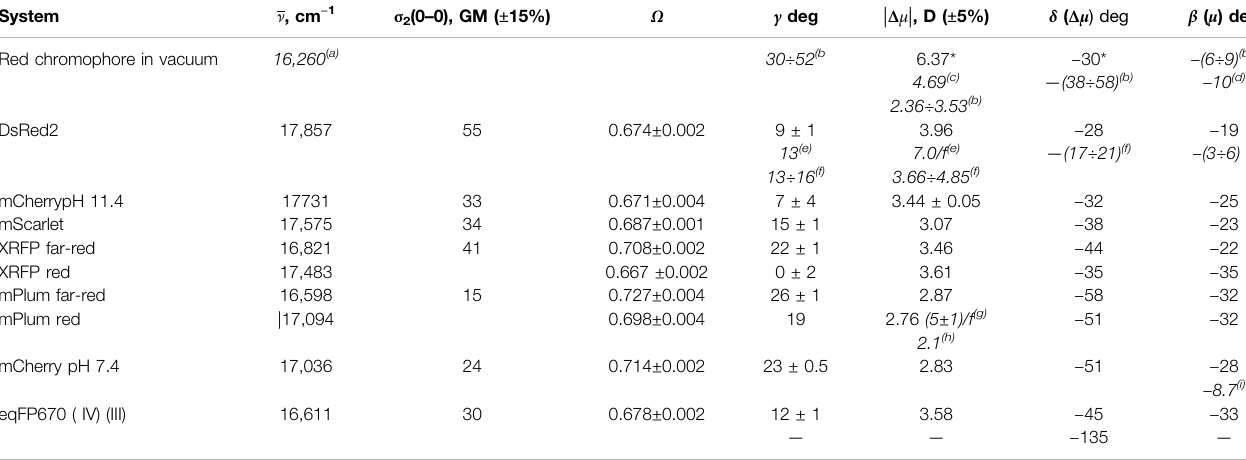
TABLE 2 | Permanent dipole moment difference vector with its length